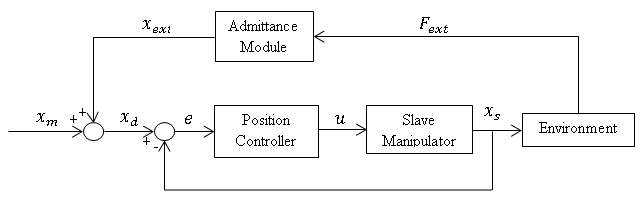
Figure 2. General block diagram of admittance control.